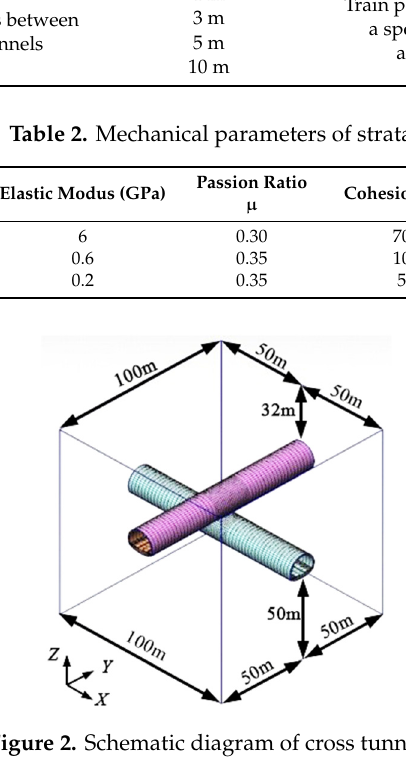
Table 2. Mechanical parameters of strata.